Question: Give a one-sentence summary of this figure.
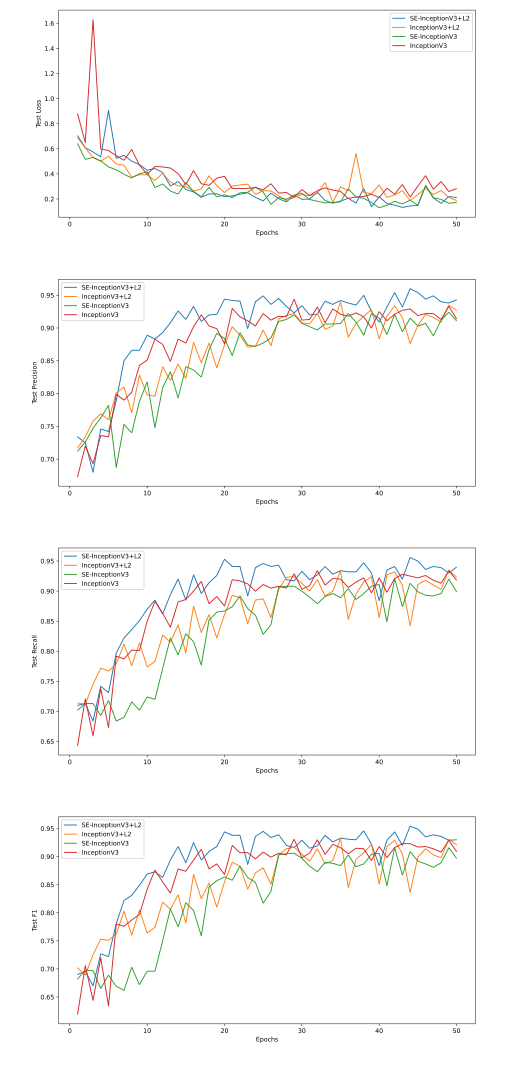
Answer: Loss, Precision, Recall, and F1 curves for